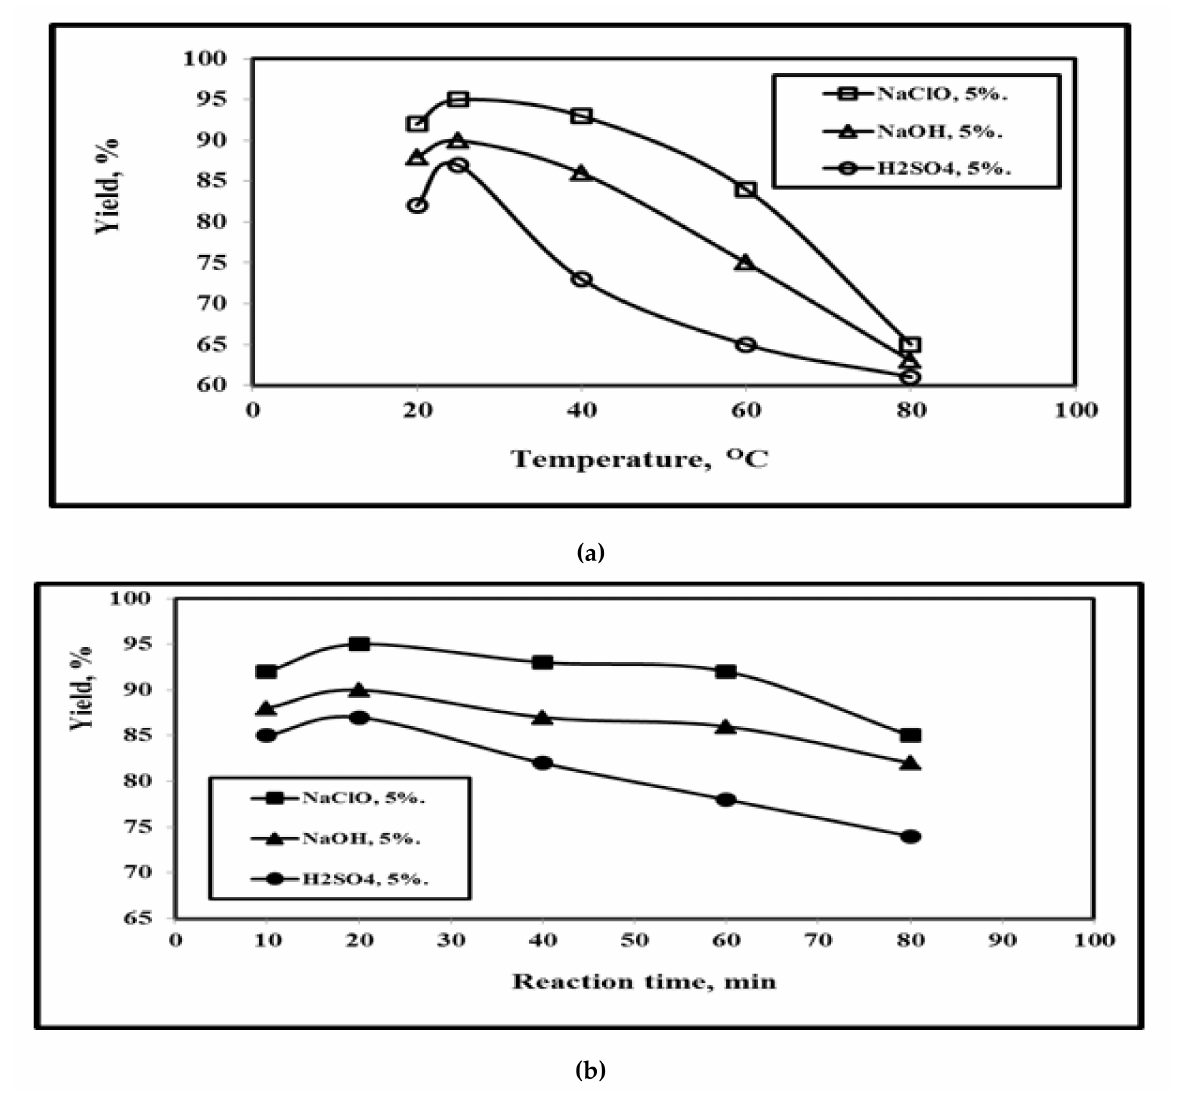
Figure 3. Effect of test temperatures and reaction times on the yield % of GNFC/5% NaClO, GNFC/5% NaOH, and GNFC/5% H 2 SO 4